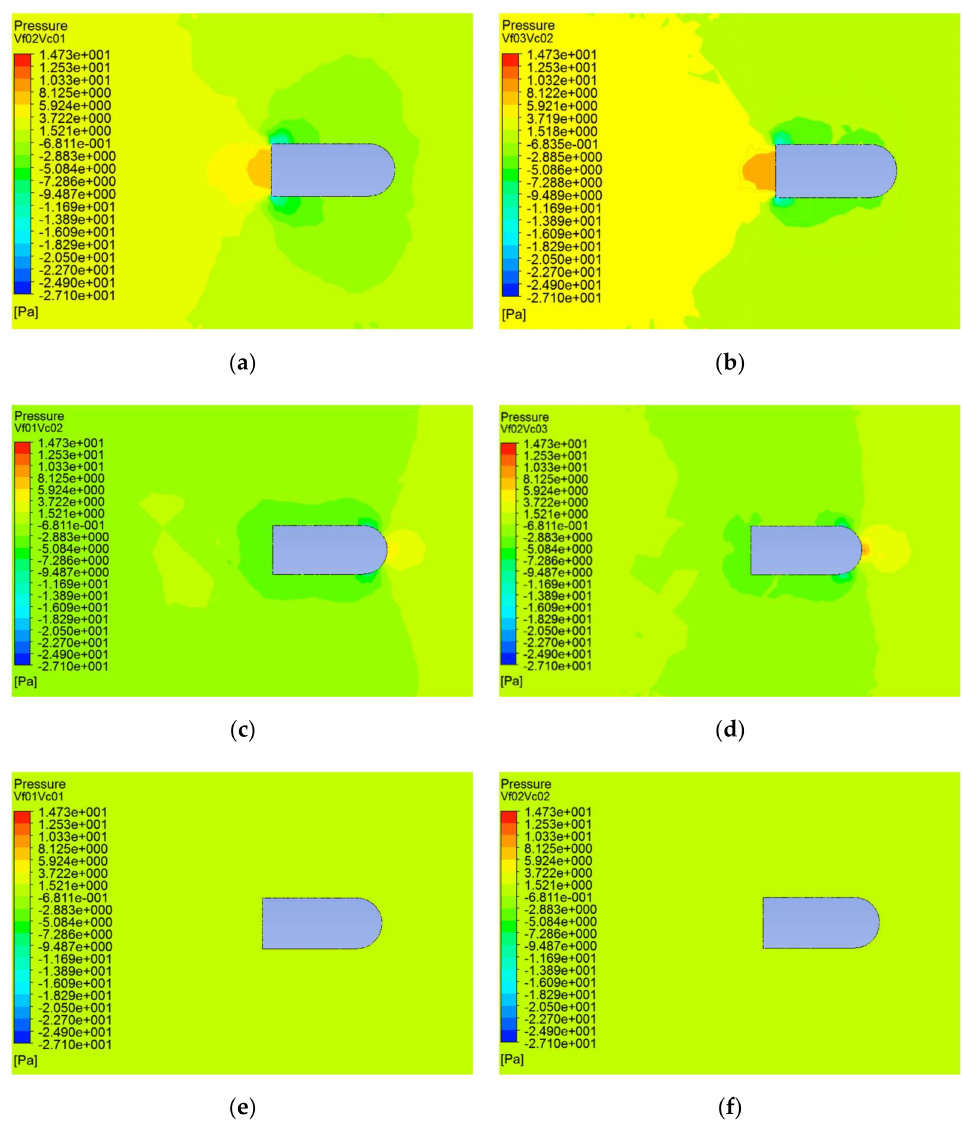
Figure 8. Cloud diagram of pressure distribution under di ff erent working conditions. ( a ) V f = 0.2 m / s and V c = 0.1 m / s; ( b ) V f = 0.3 m / s and V c = 0.2 m / s; ( c ) V f = 0.1 m / s and V c = 0.2 m / s; ( d ) V f = 0.2 m / s and V c = 0.3 m / s; ( e ) V f = 0.1 m / s and V c = 0.1 m / s; ( f ) Vf = 0.2 m / s and V c = 0.2 m /